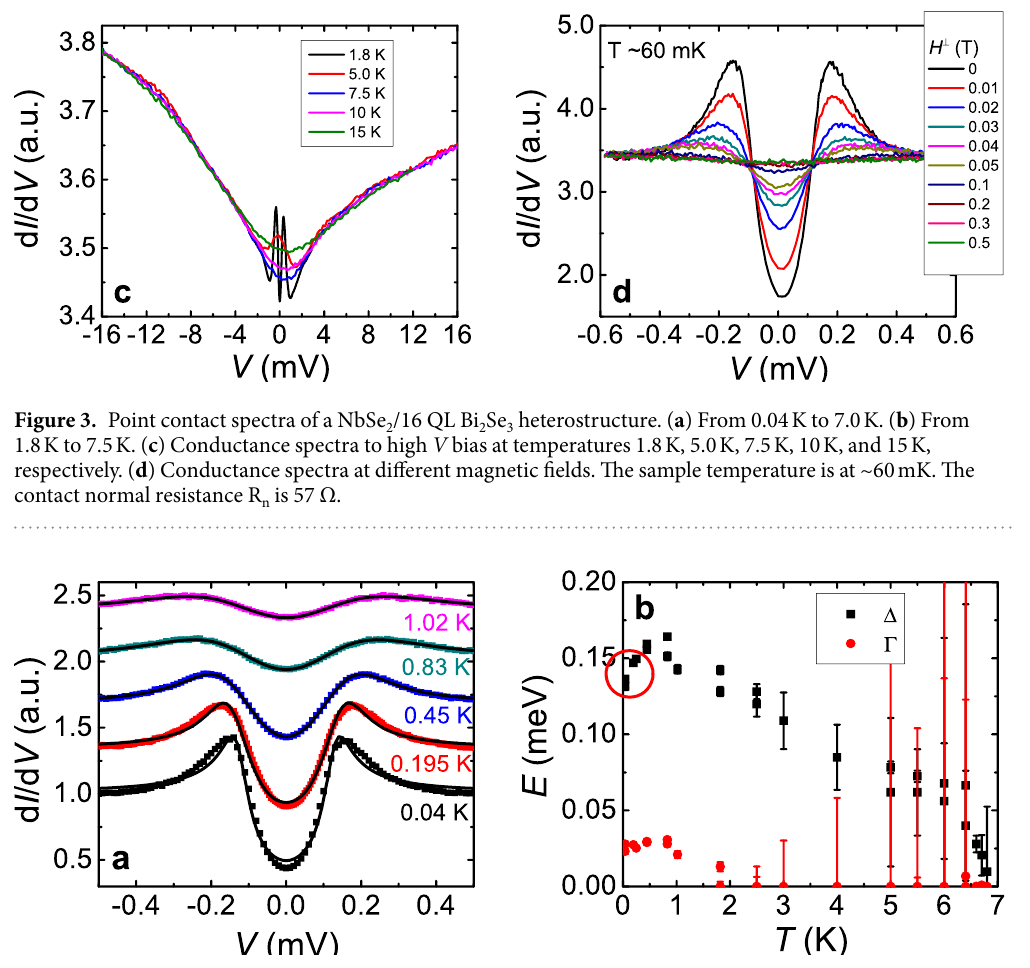
Bi 2 Se 3 at low temperatures down to 40 mK. The barrier strength parameter Z from the fittings is ~1 for all tem- peratures, indicating high tunneling barrier strength. The fitted gap value Δ and broadening parameter Γ versus